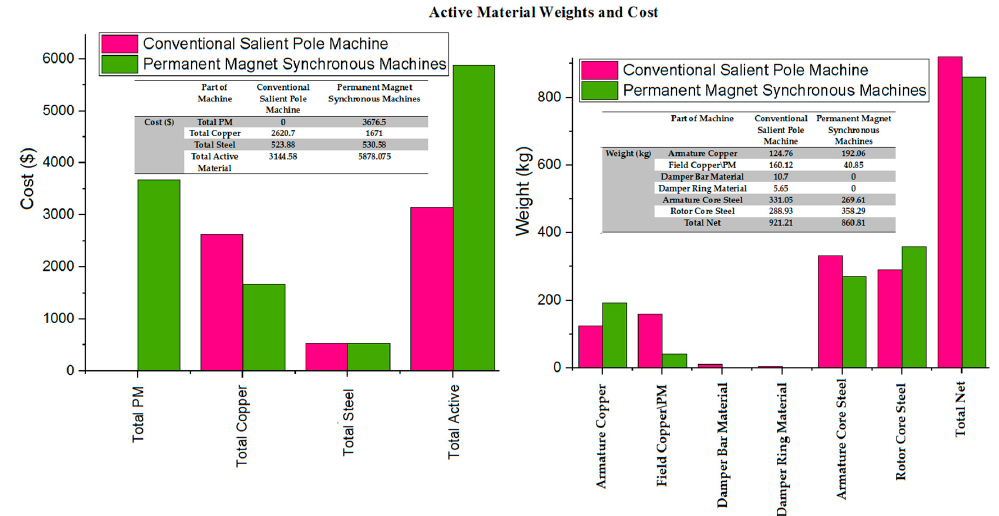
Figure 7. Active material weights and Cost comparison of PMSM and conventional machines [29].